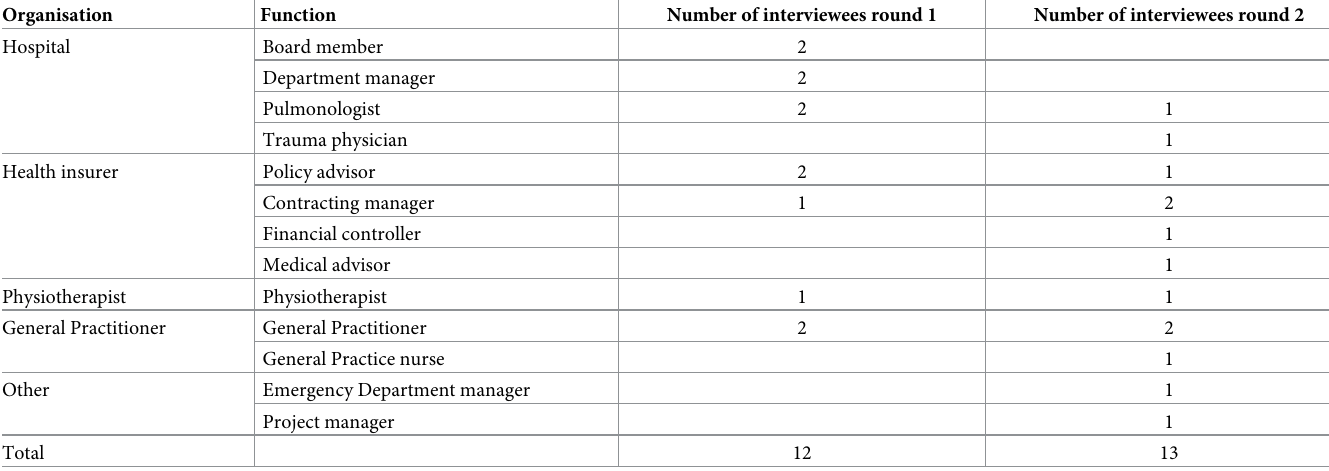
Table 2. Interviews related to the COPD improvement initiatives (interview duration 30–90